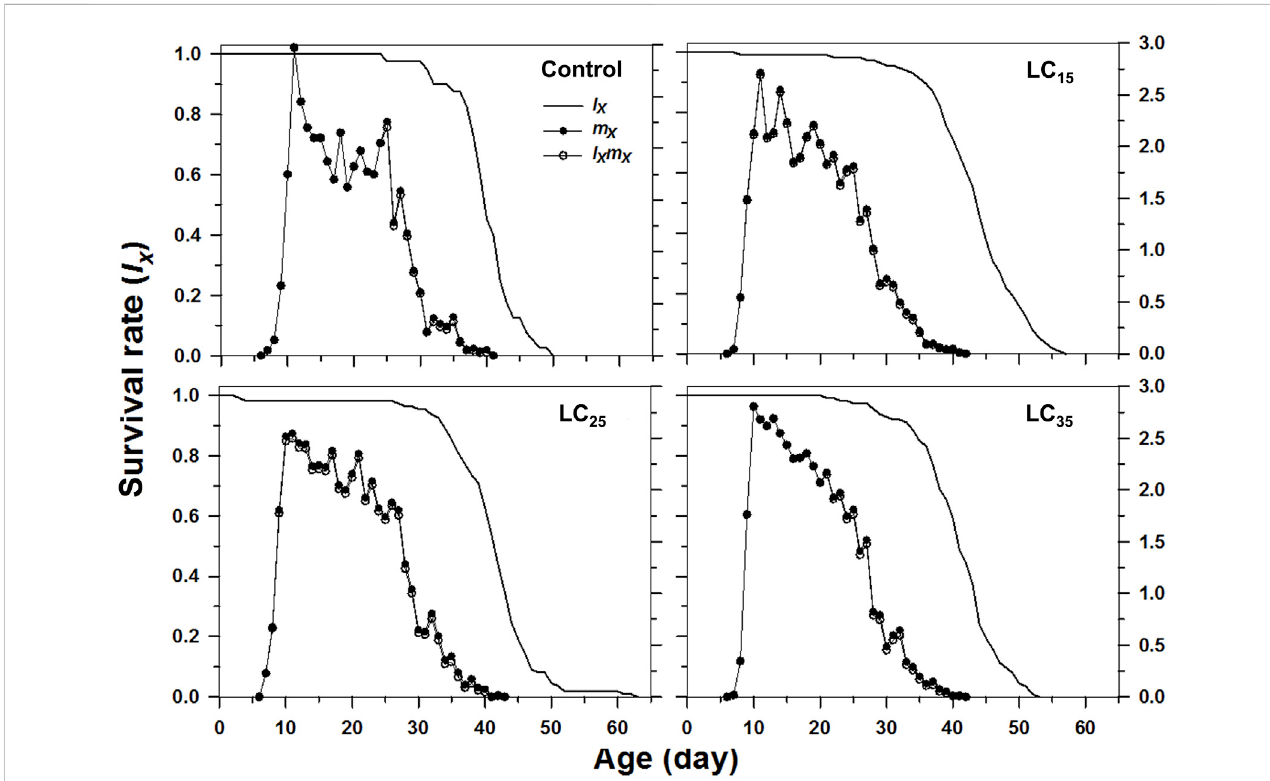
FIGURE 3 Age-specifc survival rates ( l x ), age-specifc fecundity ( m x ), and net maternity ( l x m x ) of Metopolophium dirhodum individuals of the F1 generation under control conditions, treated with 50 mg/L of imidacloprid (LC 15 ), 100 mg/L of imidacloprid (LC 25 ) and 200 mg/L of imidacloprid (LC 35 ).